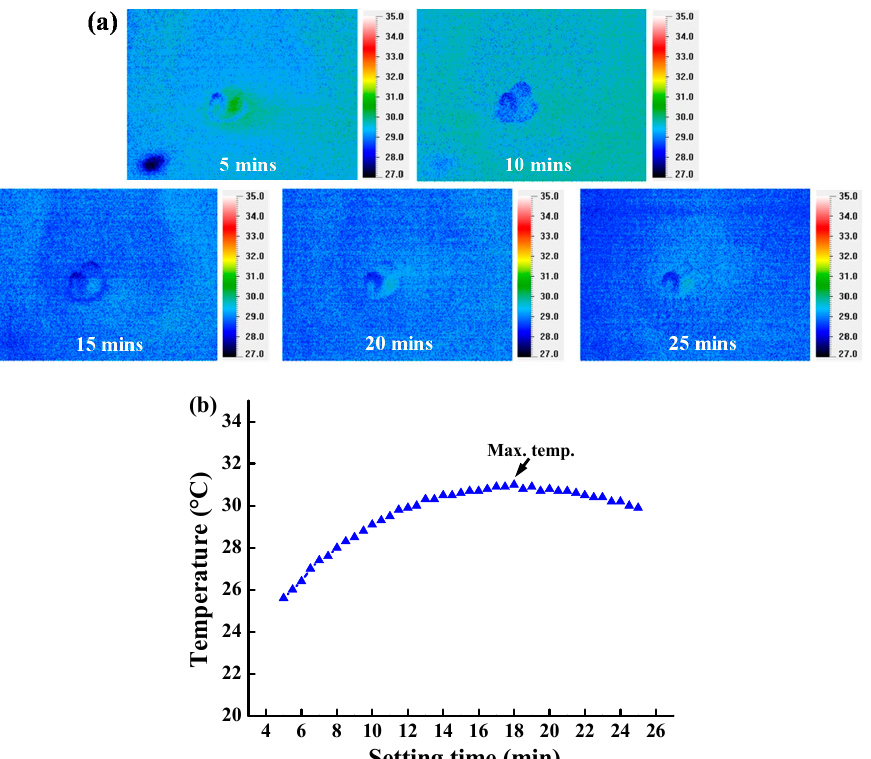
Figure 4. ( a ) Thermal images of the α -CSH bioceramic during the setting time and ( b ) the relationship between the maximum temperature and setting time.